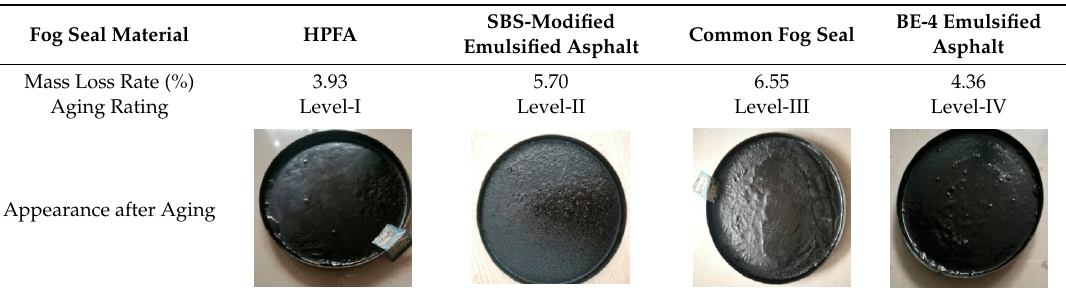
Table 7. Aging test results of different types of fog seal.